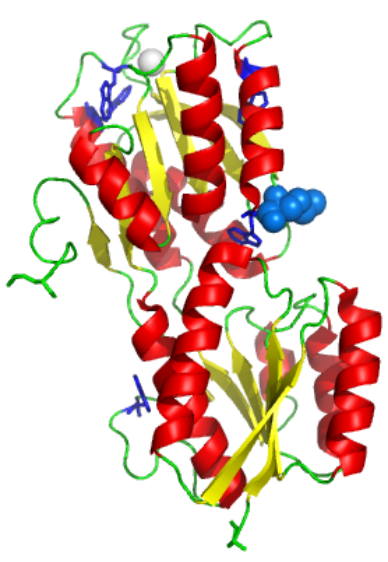
Figure 1. Three-dimensional structure of GGBP from E. coli.